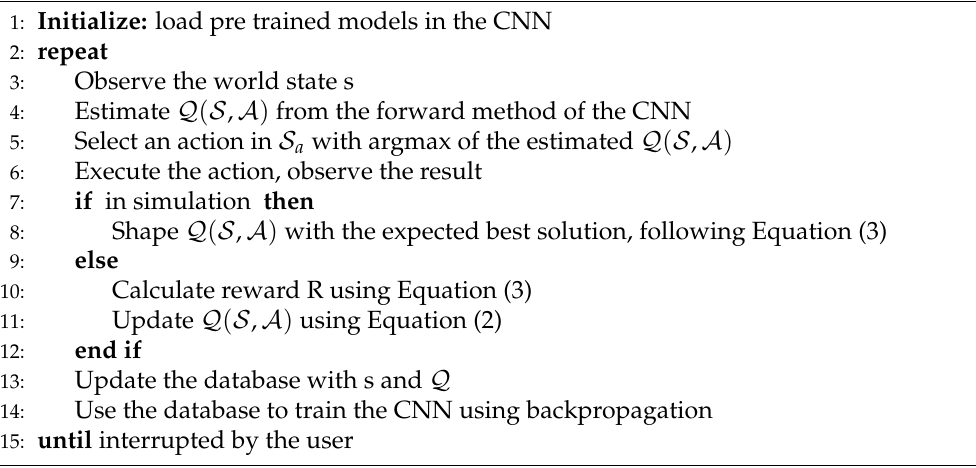
Algorithm 1 RL CNN Q-learning algorithm